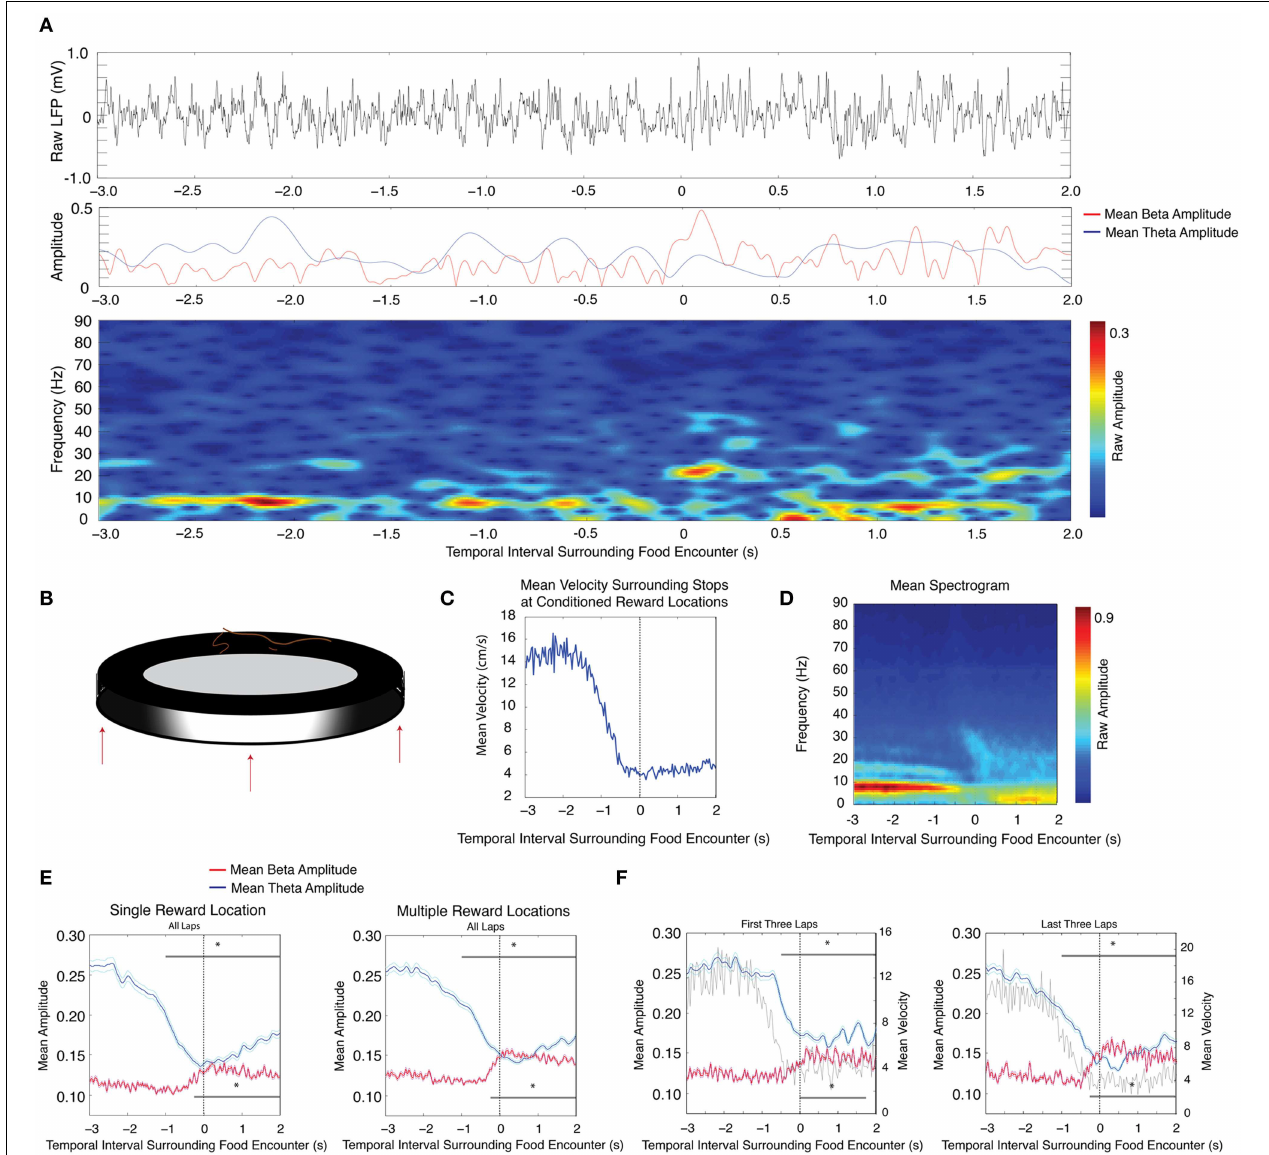
FIGURE 1 | Decreases in theta (4–12Hz) amplitude and increases in beta (15–30Hz) amplitude in response to conditioned reinforcement in a circular track paradigm. (A) Upper: Raw LFP trace as the rat approaches and stops at the reward location. The zero time point indicates a stop at the reward location. Middle: Instantaneous theta amplitude (blue) or beta amplitude (red) during the same time interval as the raw LFP trace. Lower: Gabor spectrogram during the same time interval as the raw LFP trace. (B) Cartoon schematic of the circular track apparatus with up to three example reward locations shown. (C) Mean velocity during intervals surrounding stops at conditioned reward locations. (D) Mean spectrogram across all sessions and all rats. Large amplitude 16Hz oscillations prior to stops at